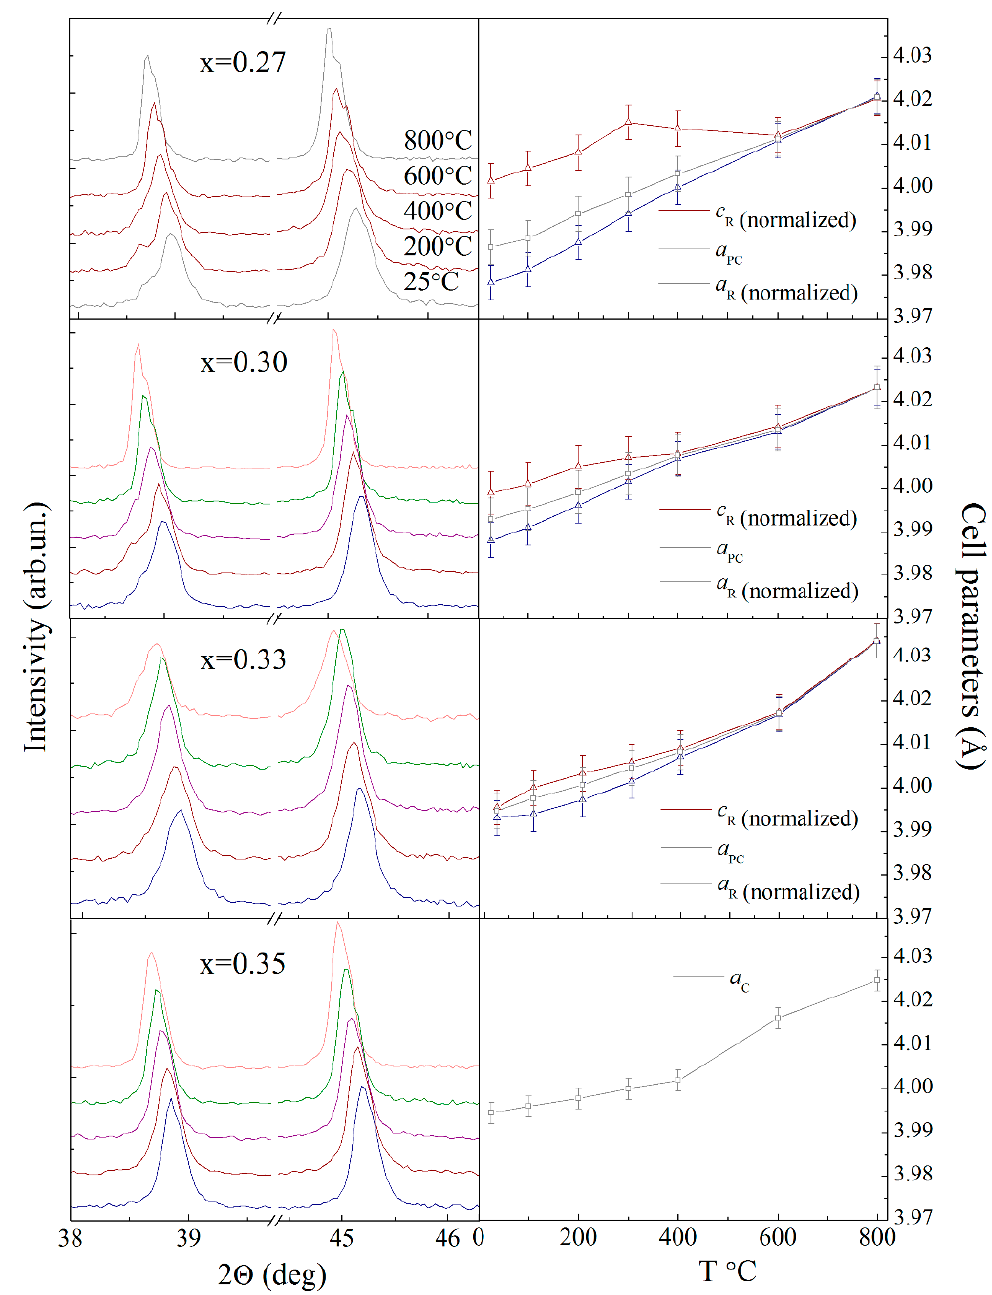
Figure 6. Temperature evolution of the di ff raction peaks 006 | 202 R (located at ~38.9 deg.) and 024 R (located at ~45.2 deg.) and the unit cell parameters calculated for the compounds with 0.27 ≤ x ≤ 0.35.